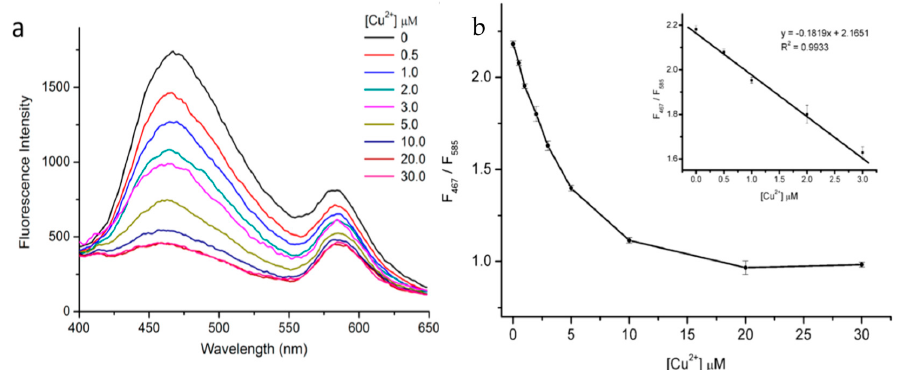
Figure 24. ( a ) Fluorescence spectra at di ff ering Cu 2 + concentrations and ( b ) plot of fluorescence intensity ratio ( F 467 / F 585 ) v. Cu 2 + concentration, with inset linear fitting curve. Reprinted with permission from reference [87]. Copyright (2014) American Chemical